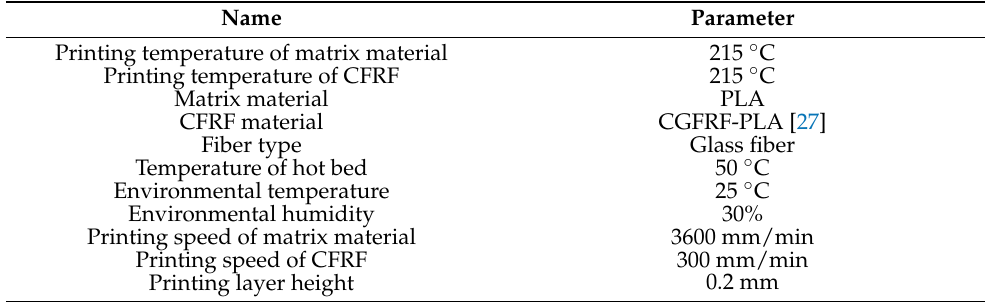
Figure 8. Definition diagram of fit degree. Table 2. The printing parameters.